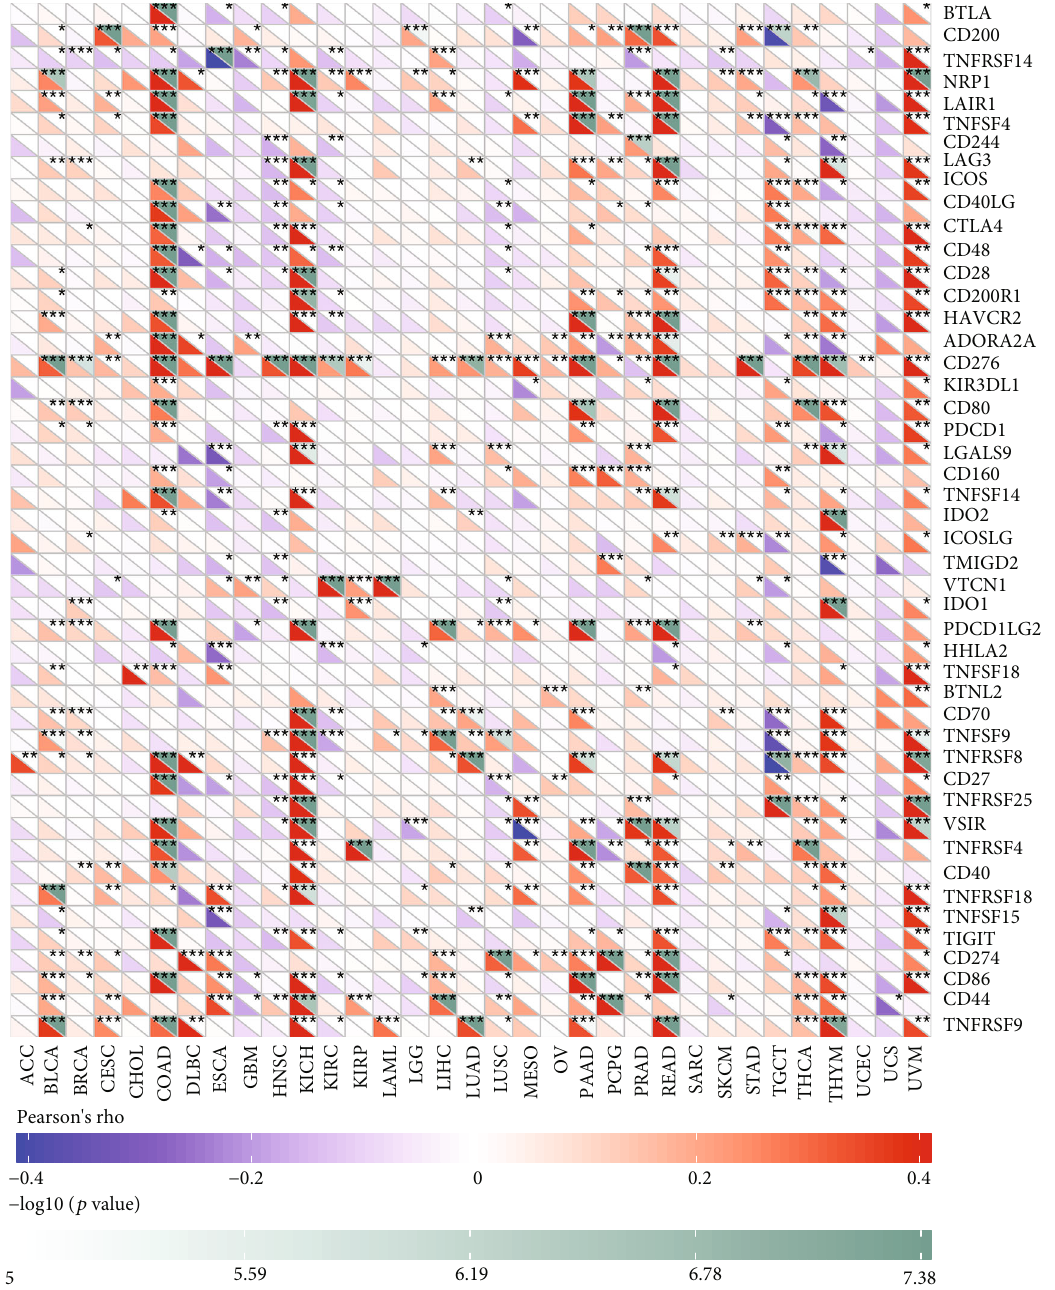
Figure 8: Correlation of B4GALNT1 expression with 47 common immune checkpoint gene expression across cancers. ∗ P < 0 : 05 , ∗∗ P < 0 : 01 , and ∗∗∗ P < 0 : 001